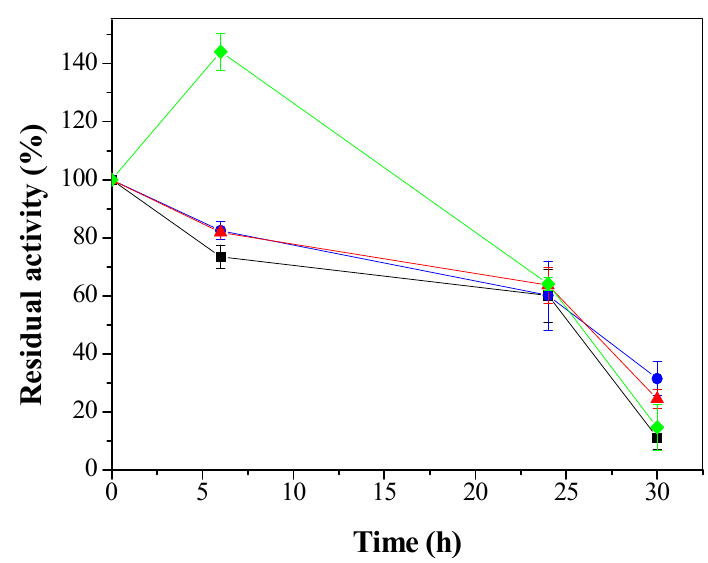
Figure 9. Residual activity (%) related to pH variation for free LU (solid) and immobilized LU (striped) in CTA. The error bars are derived from triplicates.